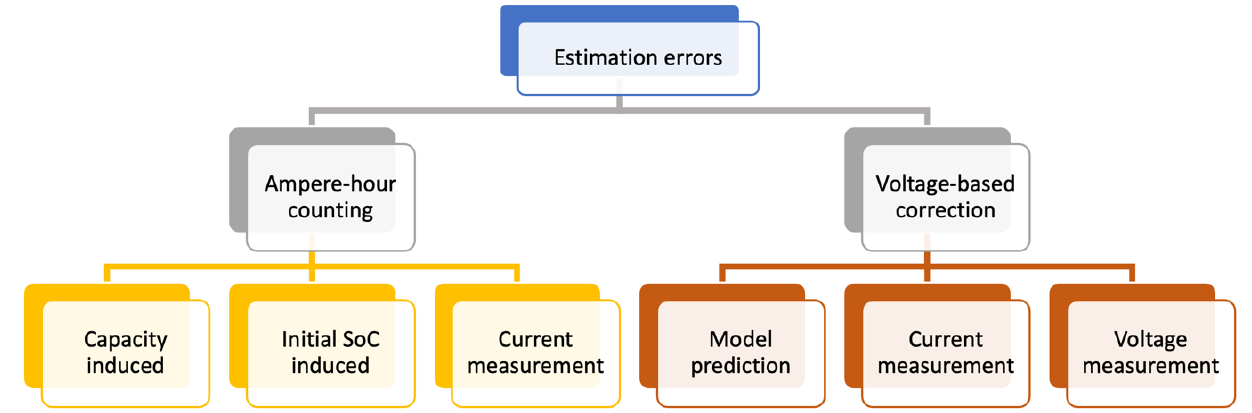
Figure 6. Sources of errors in model-based approaches to state-of-charge estimation in battery electric vehicle Lithium-ion batteries.